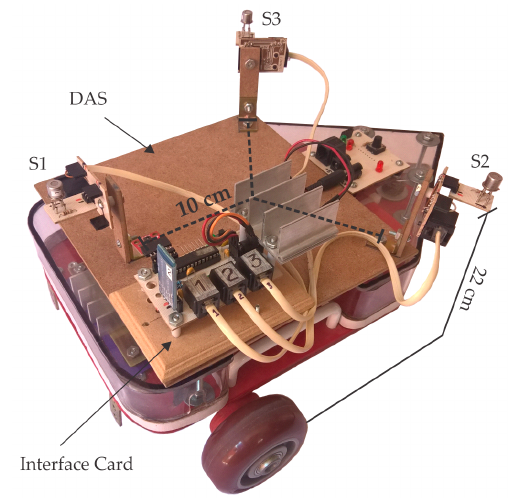
Figure 3. Robotic platform with the DAS. The three TGS2620 sensors are at a height z 0 = 22 cm.